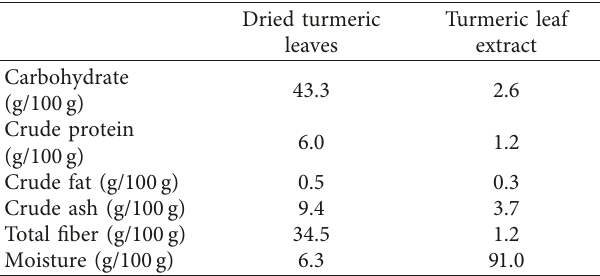
Table 3: Proximate composition content (g/100g) of turmeric leaves and the turmeric leaf